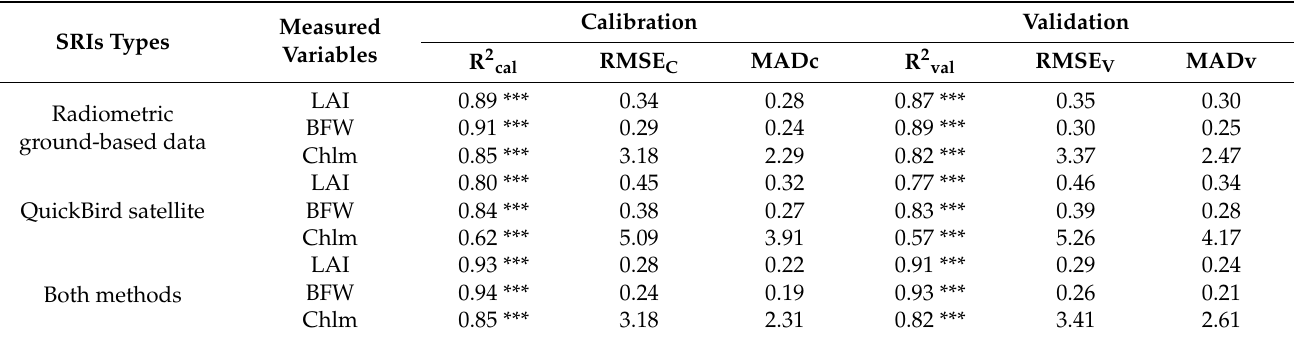
Table 7. Results of calibration (R 2 cal , RMSE C and MADc), and 10-fold cross-validation (R 2 cal , RMSEv and MADv) of multiple linear regression models (MLR) of the relationship between selected spectral reflectance indices extracted in Table 1 from radiometric ground-based data, QuickBird satellite and both of them with leaf area index (LAI), biomass fresh weight (BFW) and chlorophyll meter (Chlm) of